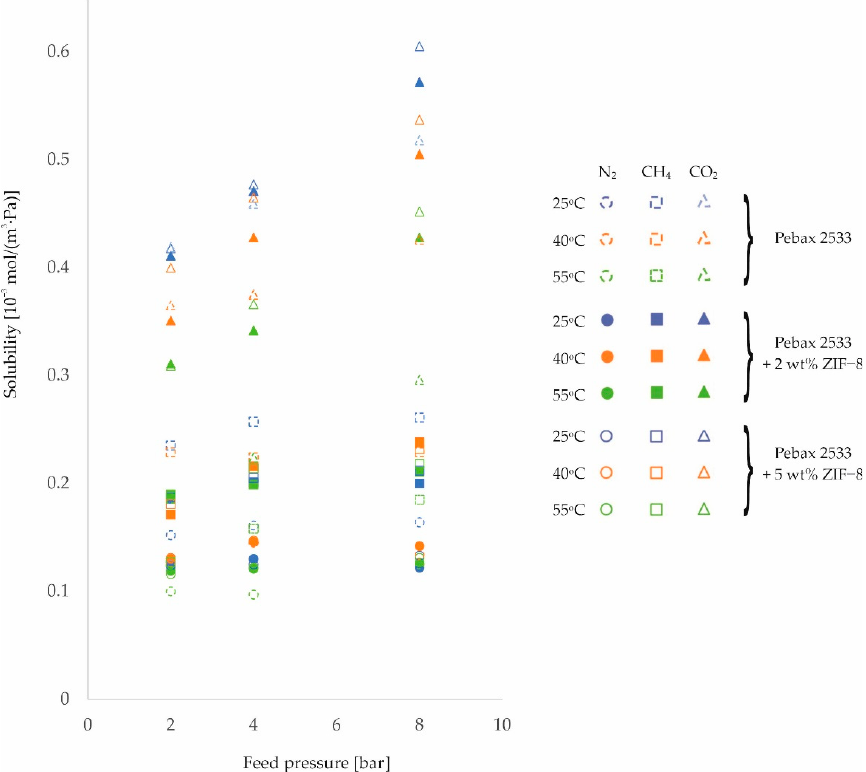
Figure 8. Change in solubility coefficient values of homogeneous membrane and heterogeneous membranes containing ZIF − 8 for different feed pressure and temperature values.